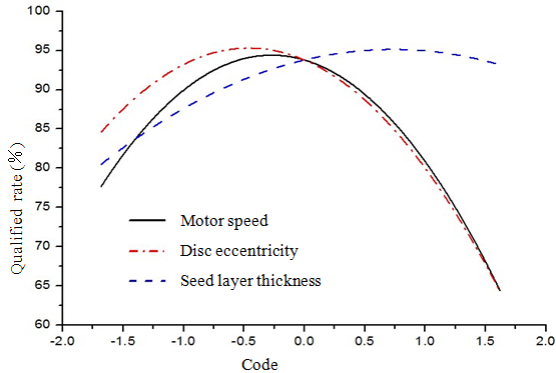
Figure 13. Influence of the single factor on the qualified rate. The results show that the relationship between the three factors and the qualified rate is a concave curve, which has a positive effect before the extreme value point and a negative effect after the extreme value point. The extreme value of the motor speed is − 0.27 (actual value 197 r/min), the extreme value point of disc eccentricity is − 0.46 (actual value is 19.5 mm), and the extreme value point of the seed layer thickness is 0.73 (actual value is 22.3 mm). The slope of the curve corresponding to the motor speed and disc eccentricity is higher, which indicates that the change in this factor has a greater disturbance on the qualified rate. The curve corresponding to the thickness of the seed layer is gentle, which indicates that the disturbance of this factor on the qualified rate was relatively